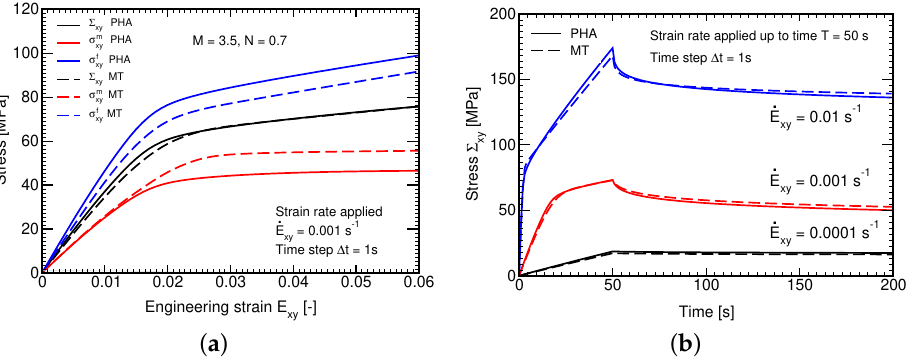
Figure 14. ( a ) Comparison of MT and PHA predictions for ˙ E xy = 1 × 10 − 3 s − 1 : evolution of stresses within individual phases, ( b ) Relaxation test: time evolution of macroscopic strain E xy